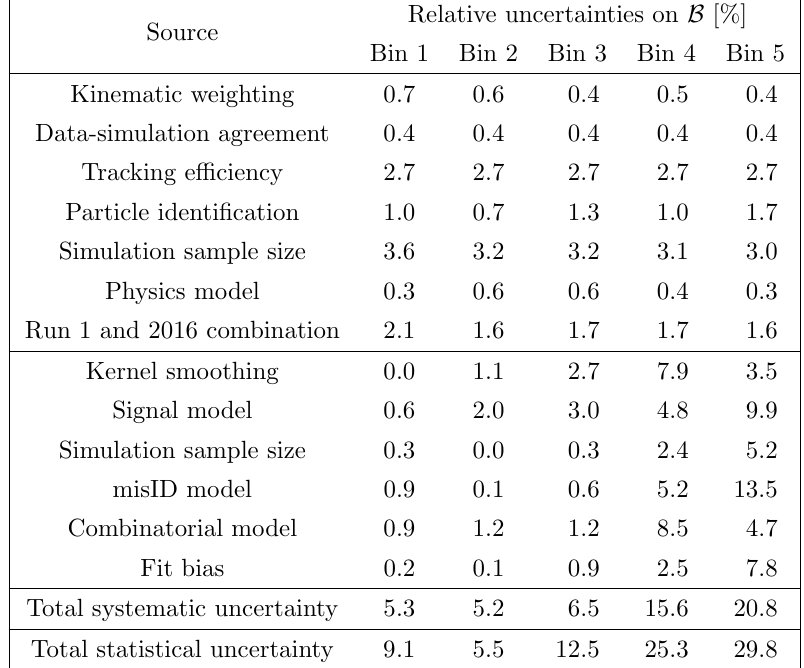
Table 2 . Summary of the systematic uncertainties on the di(cid:11)erential branching fractions. The contributions pertaining to the e(cid:14)ciency estimate are (cid:12)rst, those for the yield extraction are below. The particle identi(cid:12)cation and tracking e(cid:14)ciency uncertainties are assumed to be 100% correlated between Run 1 and 2016. The total correlations of the uncertainties between the bins are shown in table